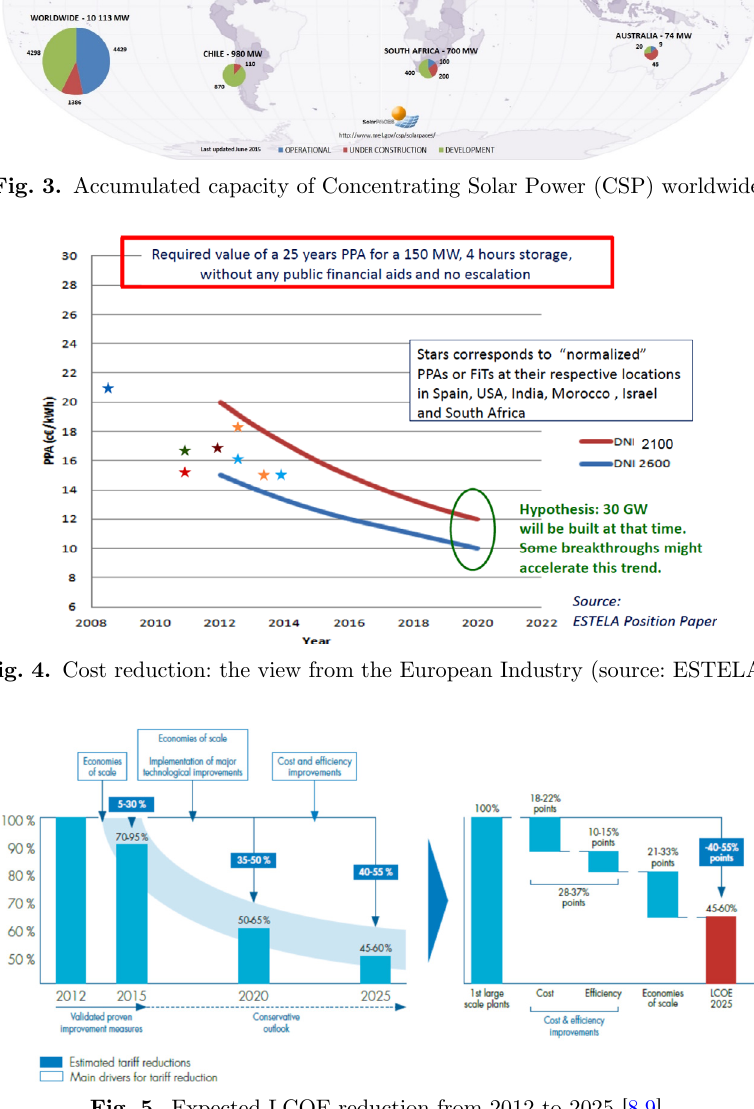
Fig. 5. Expected LCOE reduction from 2012 to 2025 [8,9].